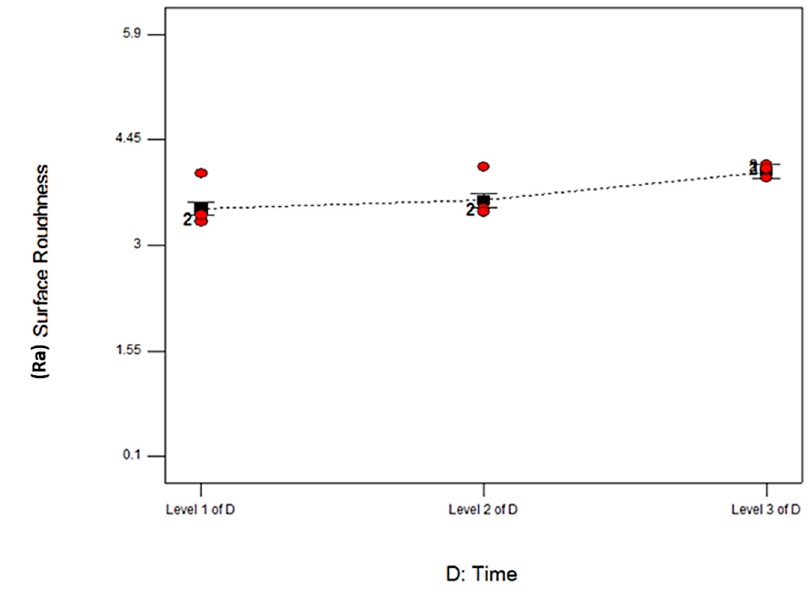
Figure 7. Contour plot for surface finish vs.